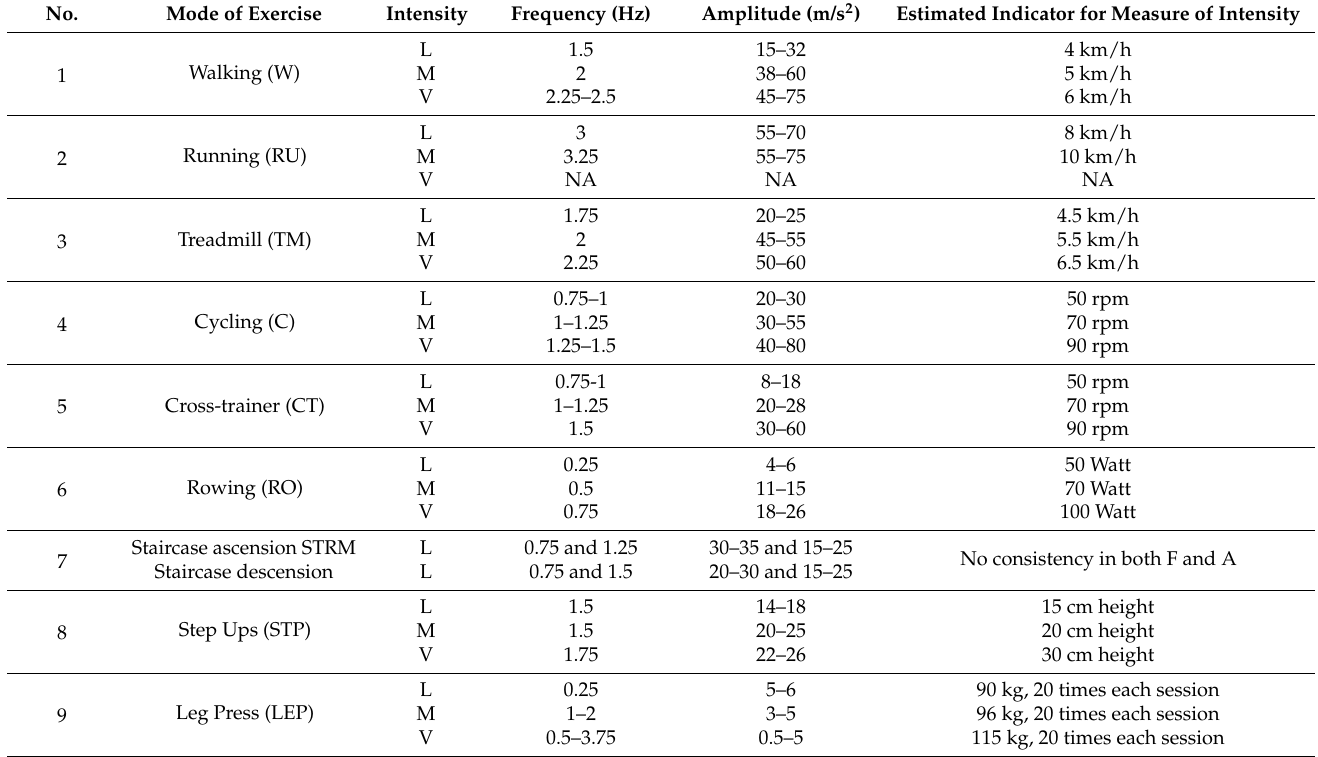
Table 3. Results of frequency analysis of 3D accelerometer data for nine different types of activity at three different intensities collected from a sensor placed on the ankle of five participants (modified from Al Naime et al.